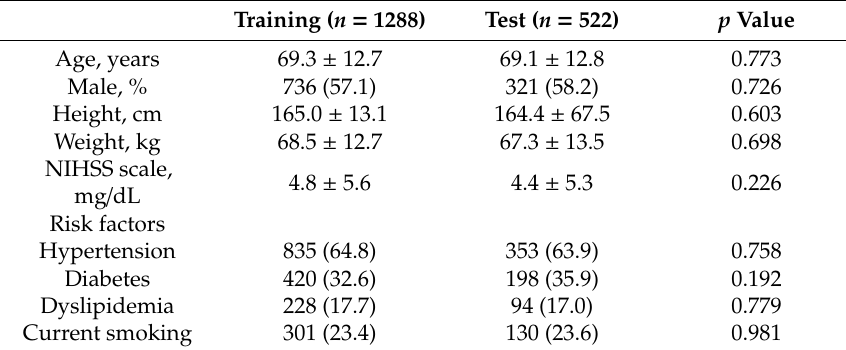
Table 2. Baseline characteristics of the total study